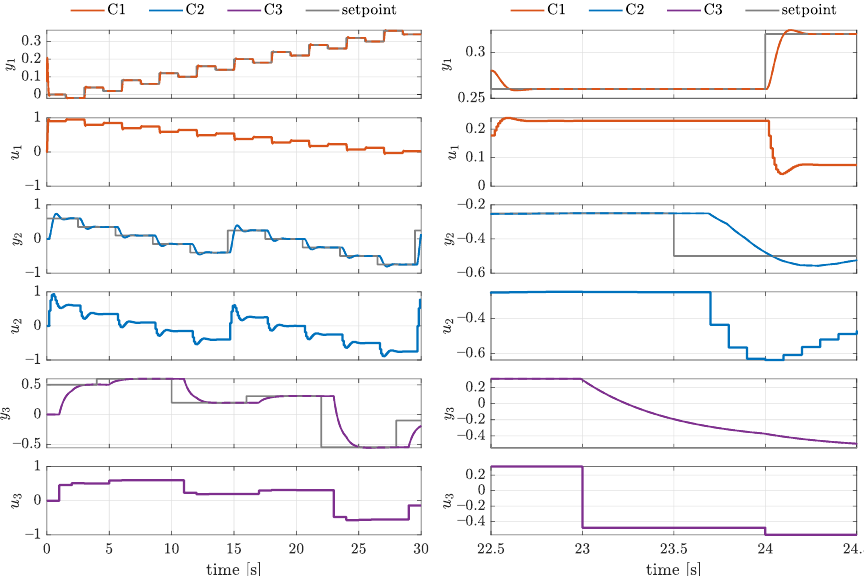
Figure 13. Results of fully simulated experiment implemented in MATLAB: full experiment ( left ) and zoomed ( right